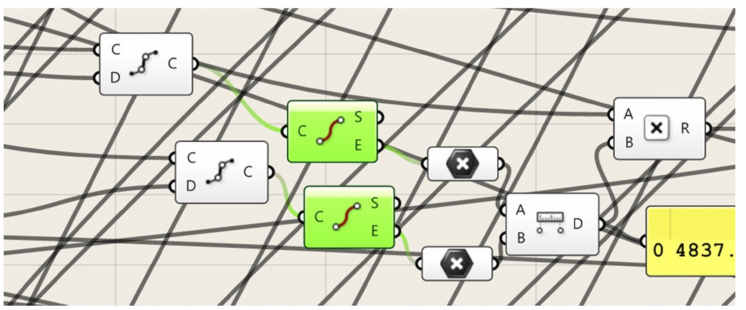
Figure 23. Components representing subcurves that are helpful in determining models e i and f i of the fold’s supporting